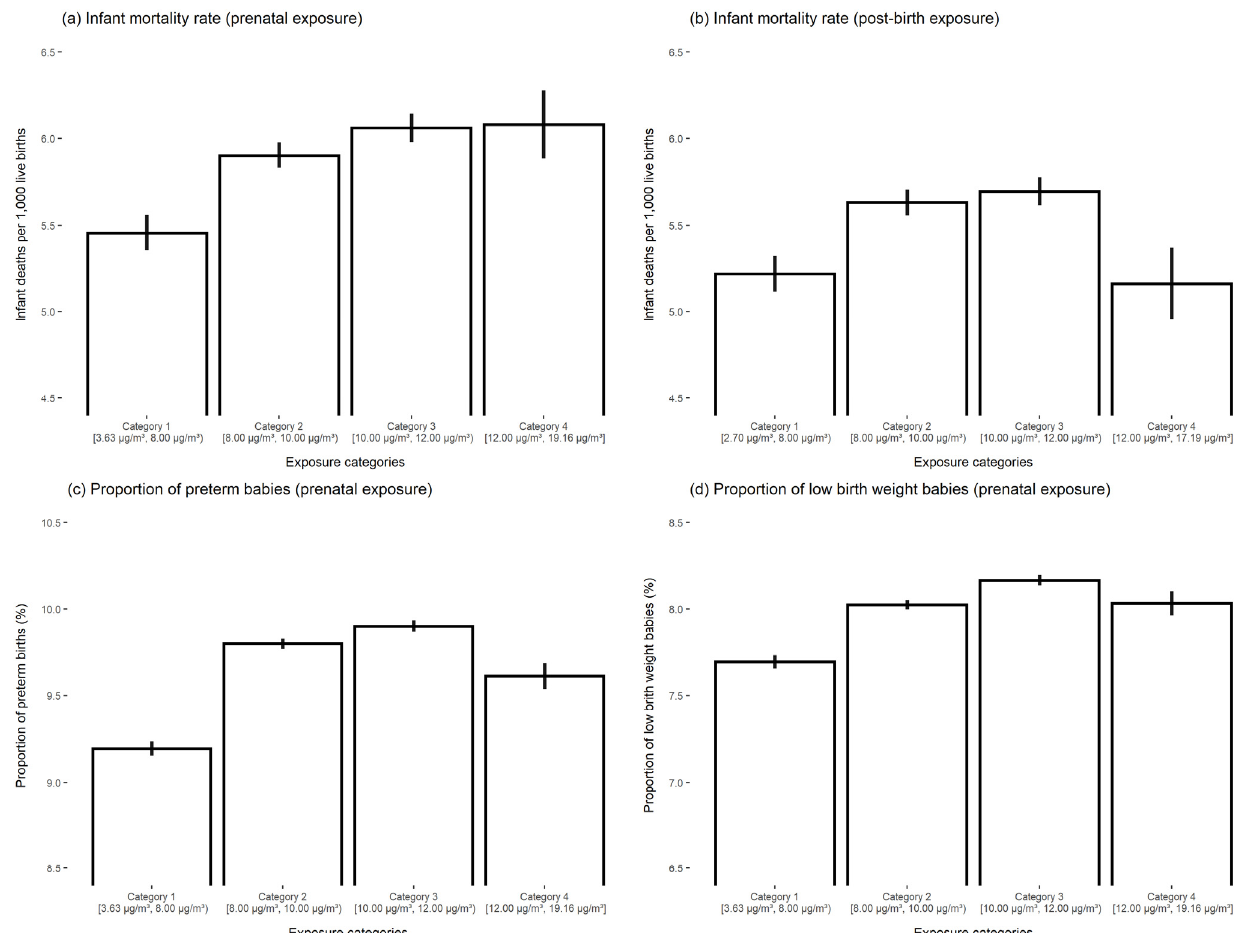
Figure 3. Unadjusted averages of infant mortality, preterm birth, and low birth weight by categories of the prenatal and post-birth PM 2.5 exposure. Notes: Prenatal exposure is defined as average PM 2.5 concentration in the pregnant person’s county of residence over the entire nine-month prenatal period. We define prenatal exposure over the entire nine-month period for ease of presentation. The categories of both prenatal and post-birth exposure are <8 μ g/m 3 ; 8–10 μ g/m 3 ; 10–12 μ g/m 3 ; and, ≥ 12 μ g/m 3 . Panel ( a ) shows unadjusted infant deaths per 1000 live births by categories of the prenatal exposure variable. Panel ( b ) shows unadjusted infant deaths per 1000 live births by categories of the post-birth exposure variable. Panels ( c , d ) show unadjusted averages of preterm birth and low birth weight by categories of the prenatal exposure variable.